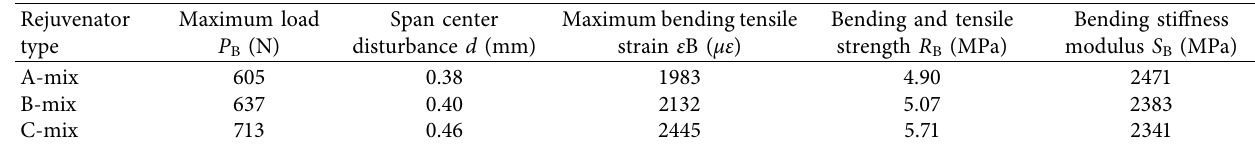
Table 8: Rejuvenated asphalt mixture − 10 ° C bending test results.